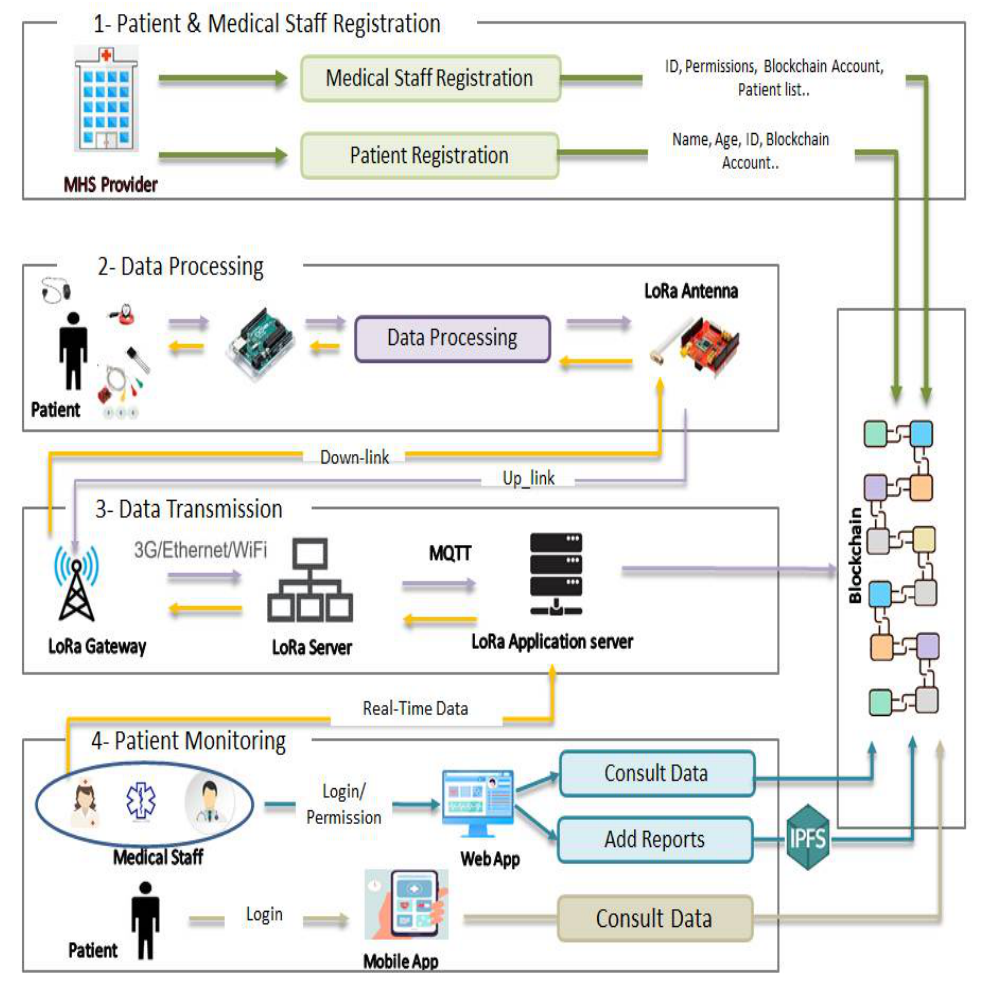
Figure 2. Proposed Architecture